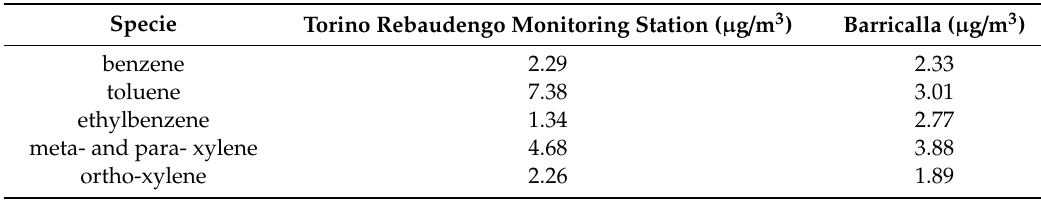
Table 8. Results of the health risk